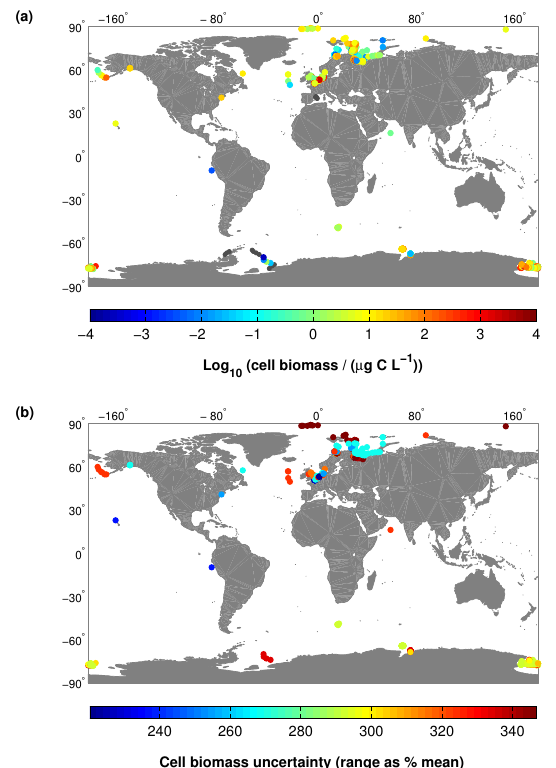
Figure 5. (a) Surface mean log-normalized Phaeocystis cell Fig. 5. (a) Surface mean log-normalized Phaeocystis cell biomass concentration in units of carbon biomass concentrations in units of carbon ( µ gCl − 1 ) and (b) range (µg C l − 1 ) and (b) range of uncertainty in cell biomass in % of the mean, due to uncertainty in cell size. of uncertainty in cell biomass in % of the mean, due to uncertainty Black dots represent zero biomass values. Data has been log-transformed for a better visualization of the in cell size. Black dots represent zero biomass values. Data has been wide range of concentrations. log-transformed for a better visualization of the wide range of con-